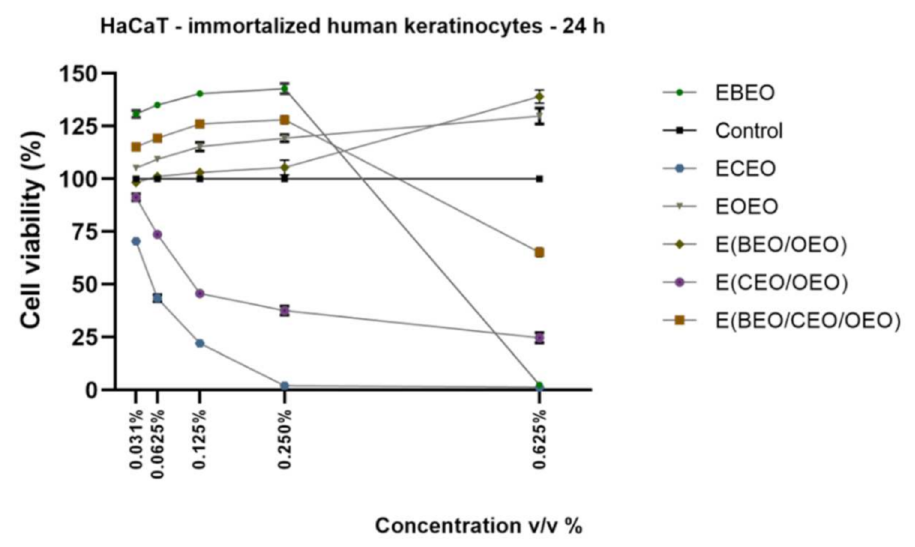
Figure 1. In vitro viability assessment of Eos emulsions (ECEO, EBEO, EOEO) and their mixtures (E(BEO/OEO), E(CEO/OEO) and E(BEO/CEO/OEO)) in HaCaT—at 24 h post-stimulation by Ala- mar blue assay. The results are expressed as cell viability percentage (%) normalized to control (unstimulated cells). The data represent the mean values ± SD of three independent